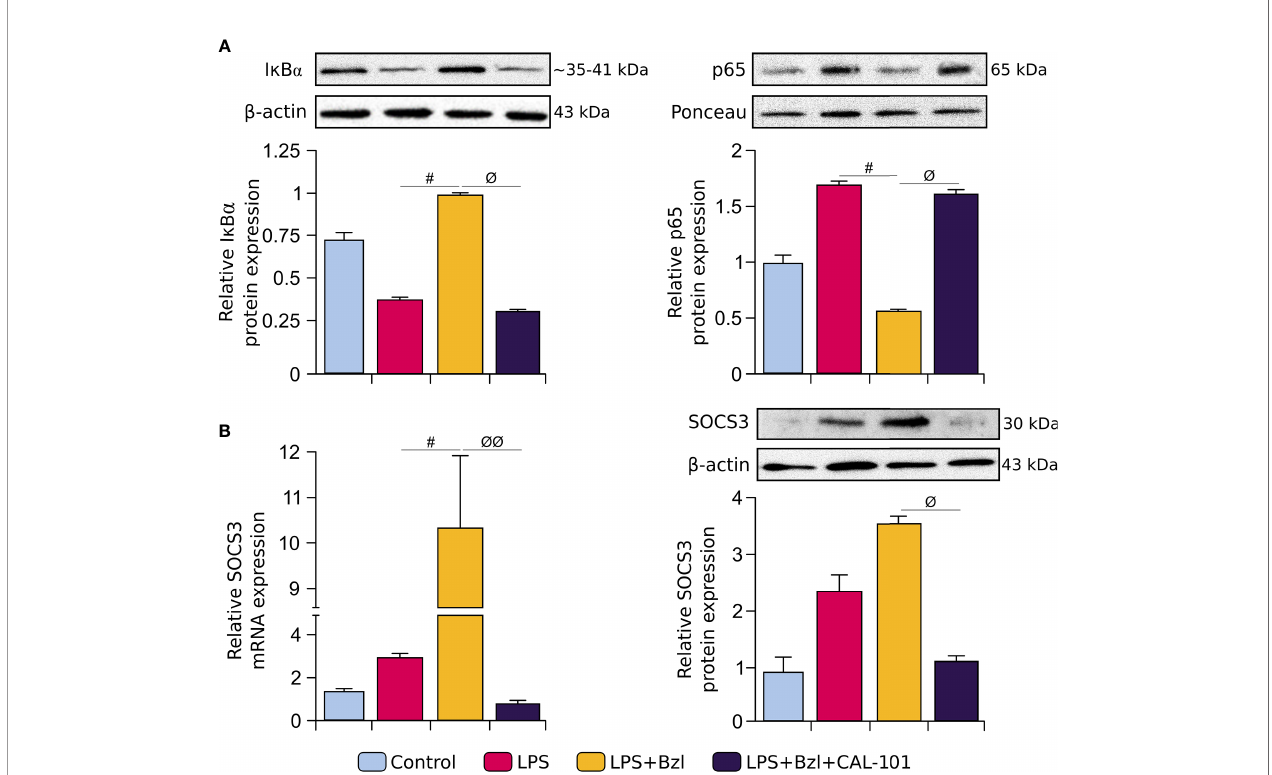
FIGURE 7 | RAW 264.7 macrophages were treated with 10 m M CAL-101, a speci fi c inhibitor of p110 d , the catalytic subunit of PI3K d isoform, 30 min before the addition of 15 m M benznidazole (Bzl). Cells were stimulated with 10 µg/mL LPS 30 min after Bzl treatment. After 30 minutes, relative cytosolic I k B a (~35-41 kDa) and nuclear p65 (65 kDa) protein expression was determined by Western blot with a speci fi c antibody and normalized against b -actin and Ponceau-staining, respectively (A) . After 24 h, SOCS3 mRNA levels were analyzed by RT-qPCR and normalized against b -actin mRNA and after 48 h, relative SOCS3 (25 kDa) protein expression was determined by Western blot with a speci fi c antibody and normalized against b -actin (43 kDa) (B) . Results are expressed as the mean of 3 independent experiments (n=3, 5 replicates/treatment) ± SEM. # P < 0.05 vs LPS-stimulated cells. f P < 0.05, ff P < 0.001 vs. Bzl-treated and LPS-stimulated